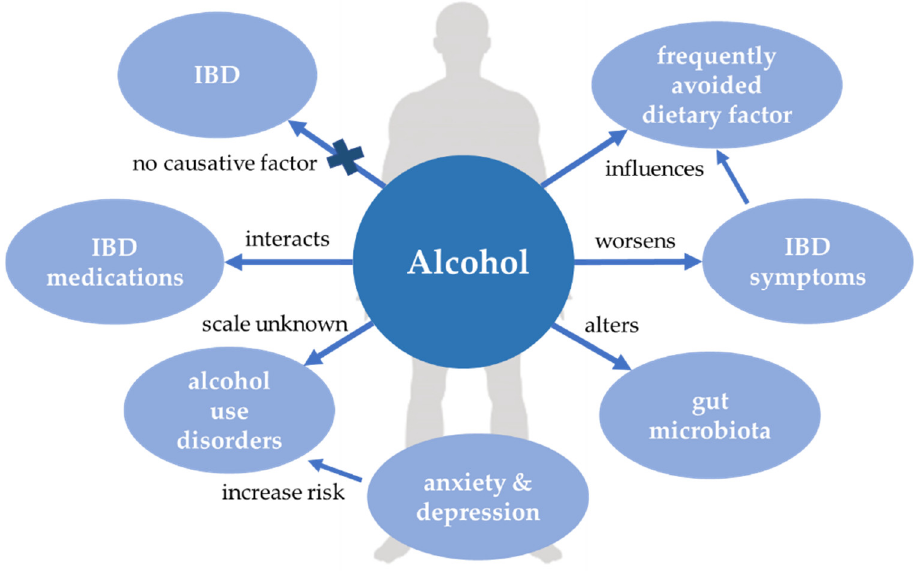
Figure 3. Alcohol and inflammatory bowel disease. IBD, inflammatory bowel disease.